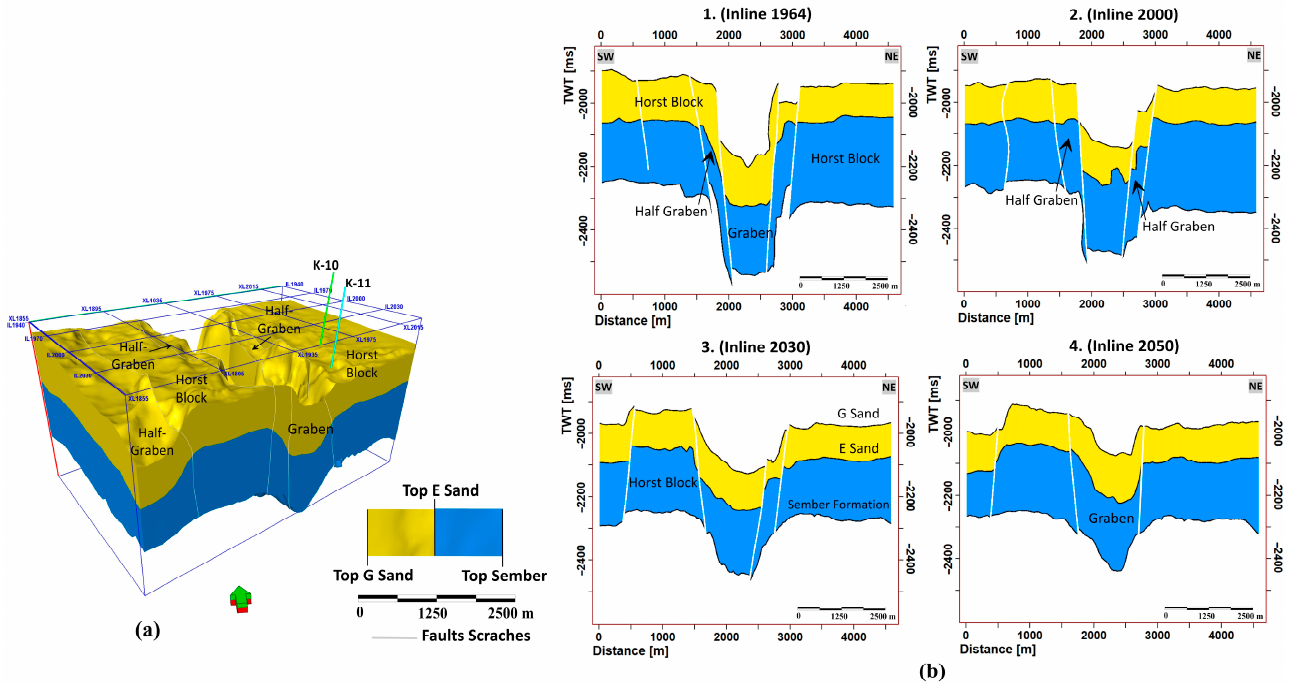
Figure 11. Final result of the 3D SM: ( a ) SW–SE view and ( b ) SW–NE oriented 2D cross-sections drawn from the 3D SM results.